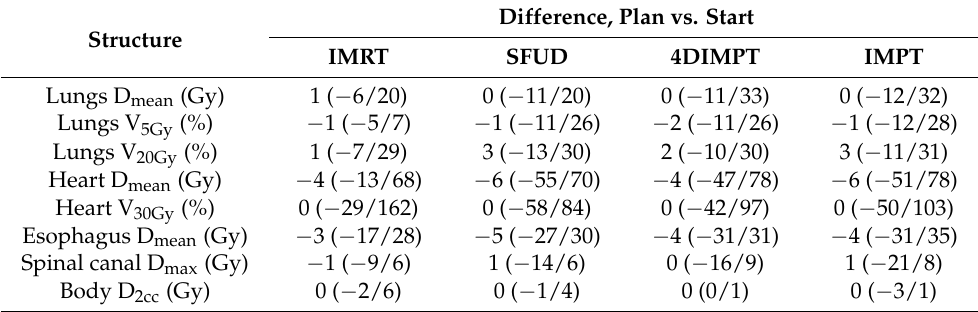
Table A5. Difference in OAR parameters from Plan to Start, relative to the Plan value. Median and range are shown for each technique. Positive values indicate a higher dose and negative values indicate a lower dose at